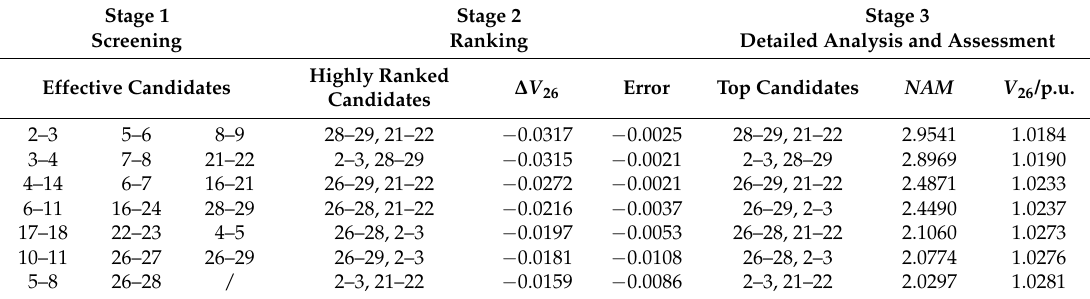
Table 3. Results of multiple lines switched off.